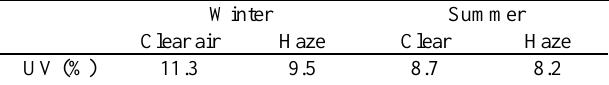
Fig. 5 Time series chart of ARE at earth surface in January (winter) and July (summer). 3.2.2 two seasons, the ARE enhanced with haze occurring. The changes in ARE fraction of UV, VIS, and NIR was displayed in Table. 2. The ARE percentage of UV and VIS in SW decreased, from clear to haze. In addition, the Variations in ARE summer. Table. 2 ARE fraction of UV, VIS, and NIR in SW